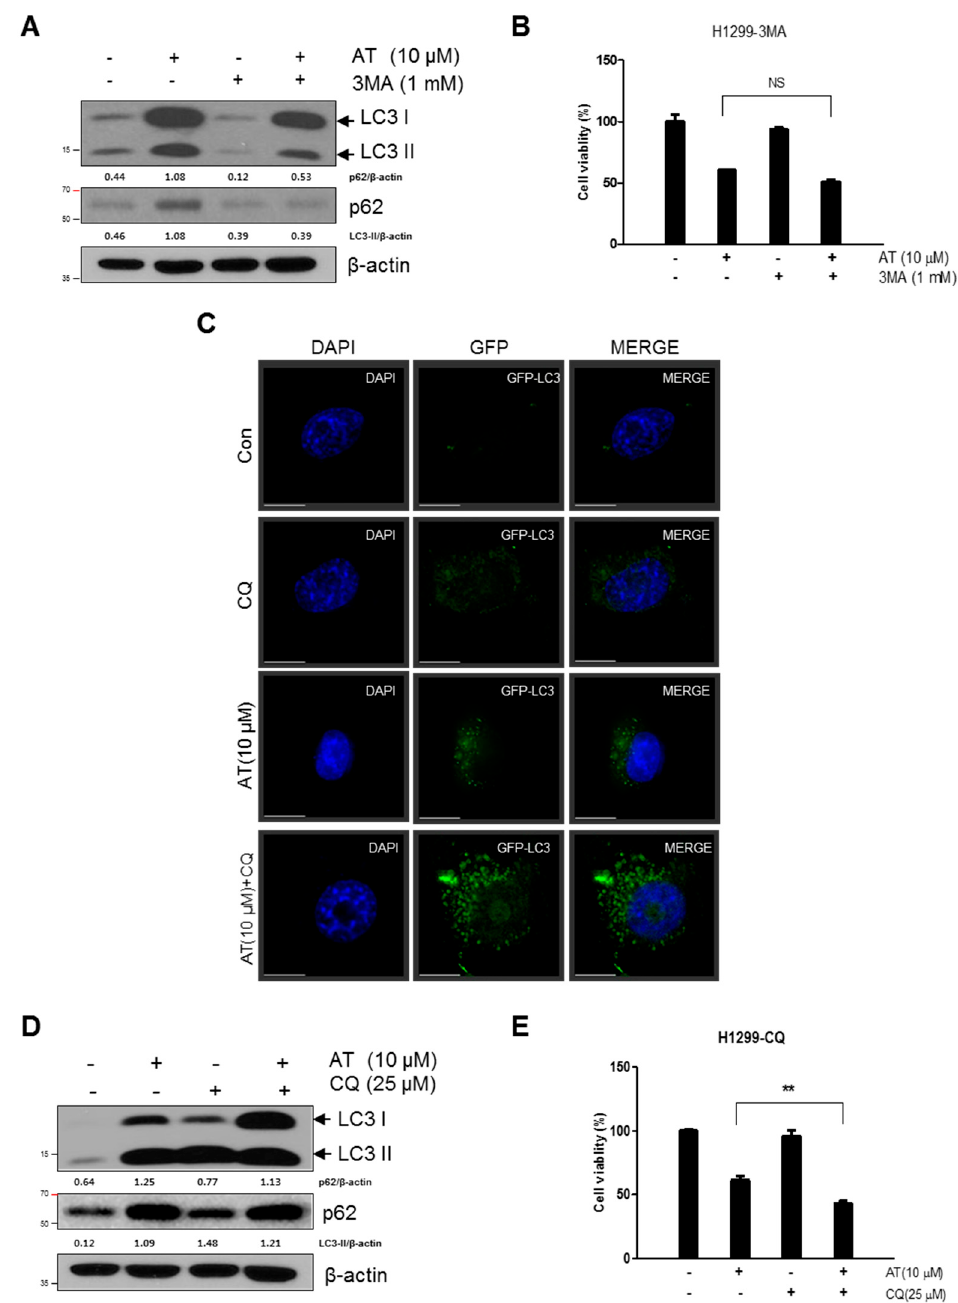
Figure 4. E ff ect of 3-MA or CQ on Atorvastatin induced-autophagy in H1299 cells. ( A ) E ff ect of 3-MA on the expression of p62 and LC3II in Atorvastatin treated H1299 cells. ( B ) E ff ect of 3-MA on cytotoxicity of Atorvastatin treated H1299 cells. ( C ) E ff ect of the autolysosome inhibitor CQ on GFP- LC3II puncta in Atorvastatin treated H1299 cells. After transient transfection with the GFP-fused LC3 plasmid, H1299 cells were treated with Atorvastatin for 48 h and were incubated with 25 µ M CQ for 12 h. The distribution of GFP-LC3II expression was visualized by confocal microscopy. Bar scale = 15 µ M, GFP-LC3-Green. ( D ) E ff ect of CQ on the expression of LC3II and p62 in Atorvastatin treated H1299 cells. Western blotting was performed to determine the expression of LC3II and p62 in H1299 cells treated with Atorvastatin for 48 h. ( E ) E ff ect of CQ on the cytotoxicity of Atorvastatin treated H1299 cells. H1299 cells were treated with Atorvastatin (10 µ M) for 48 h. Cell viability was determined by MTT assay. ** p < 0.01 vs. untreated control.